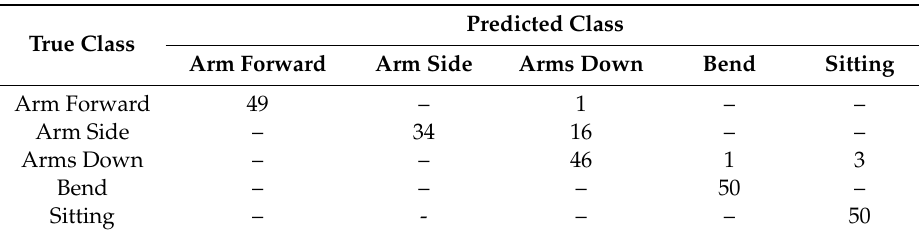
Table 11. Confusion matrix generated from implementing the Soft Voting approach to prediction selection for three corner TISs.